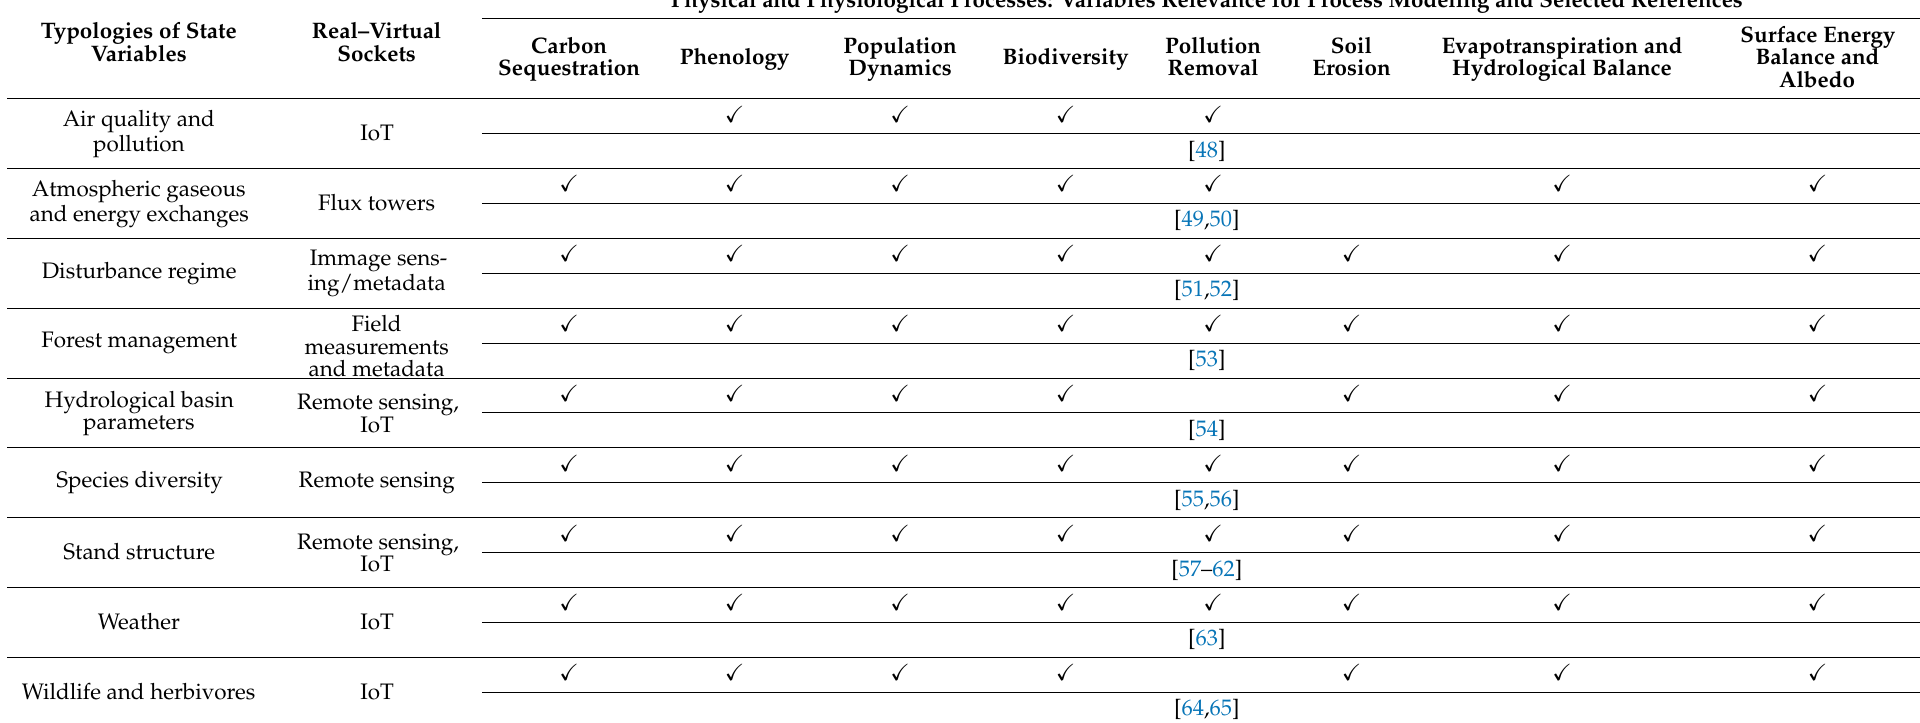
Table 2. Twinning the forest. The table reports the state variables and the related real-virtual socket. It also indicates the main relevance ( (cid:88) ) of the measured variables to model the physical and physiological processes representing the forest virtual entity, and it provides selected references for each state variable